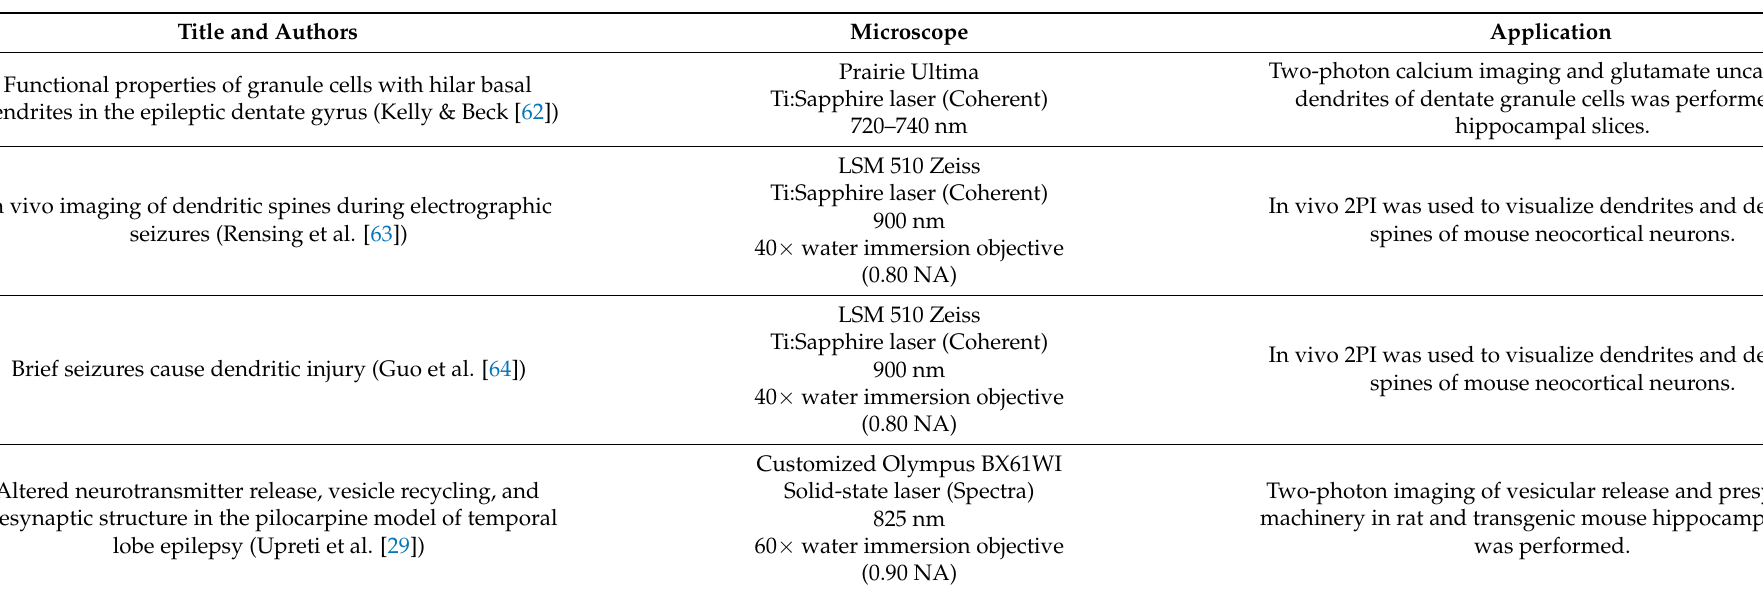
Table 5. Neurites—data abstraction table catalogues the type of two-photon microscope used and how 2PI was applied in each study within this group of publications.